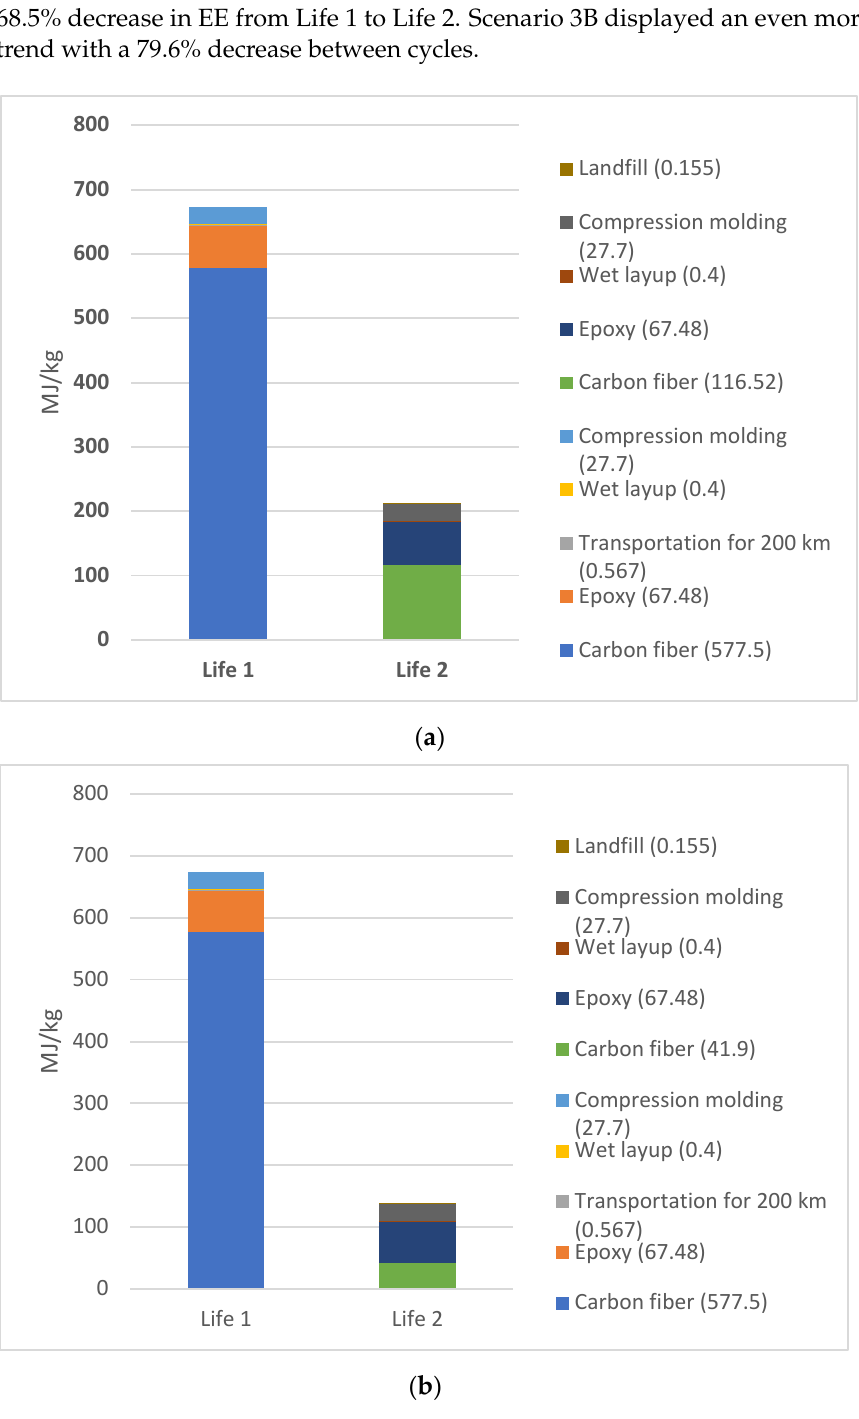
Figure 5. EE of the solvolysis process.